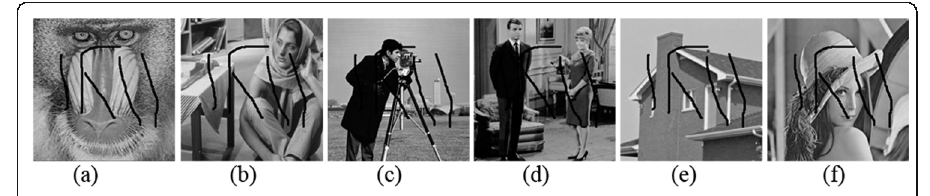
Fig. 6 Six images damaged by scratches.